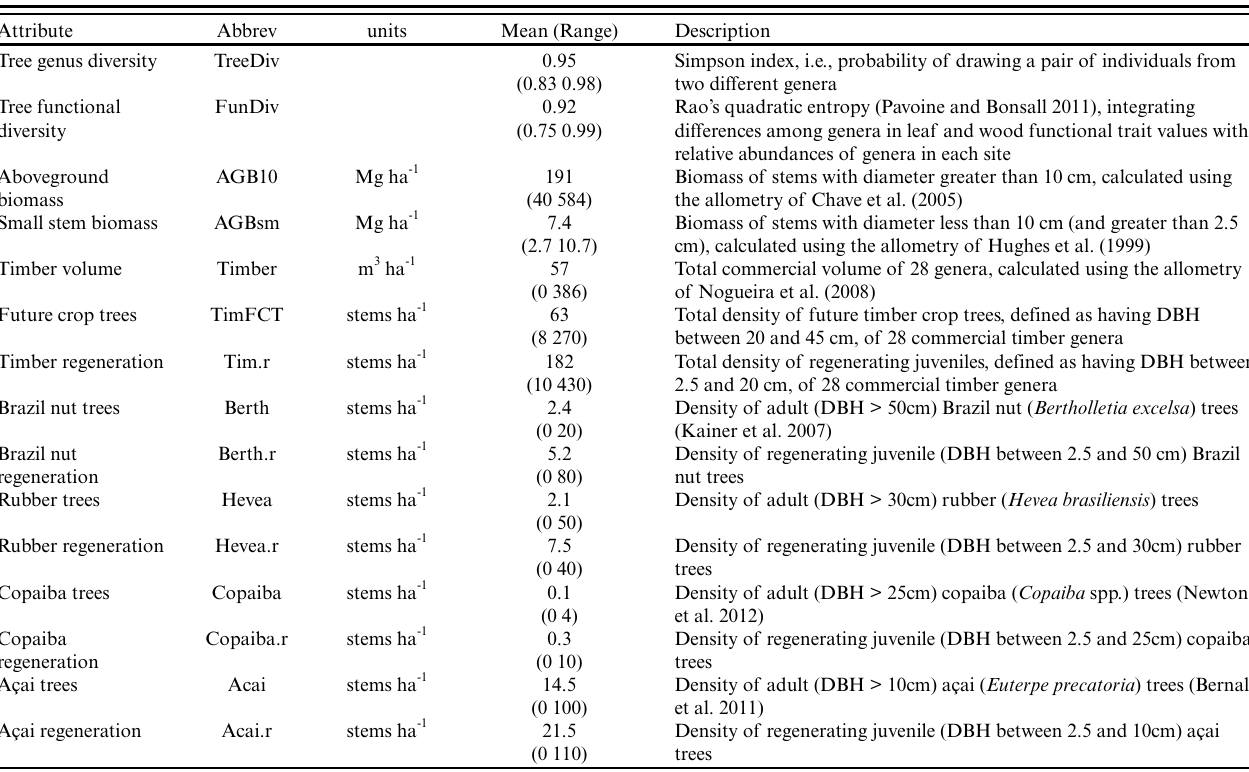
Table 1 . Forest value components defined in this study, including a code to abbreviations used in figures, their units, range, and description.